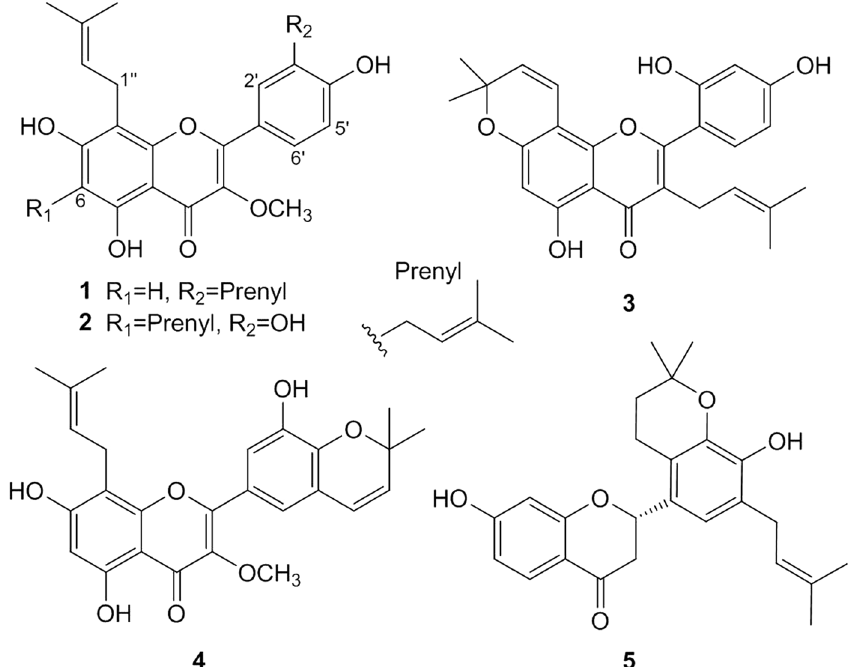
Figure 1. Chemical structures of compounds 1 – 5